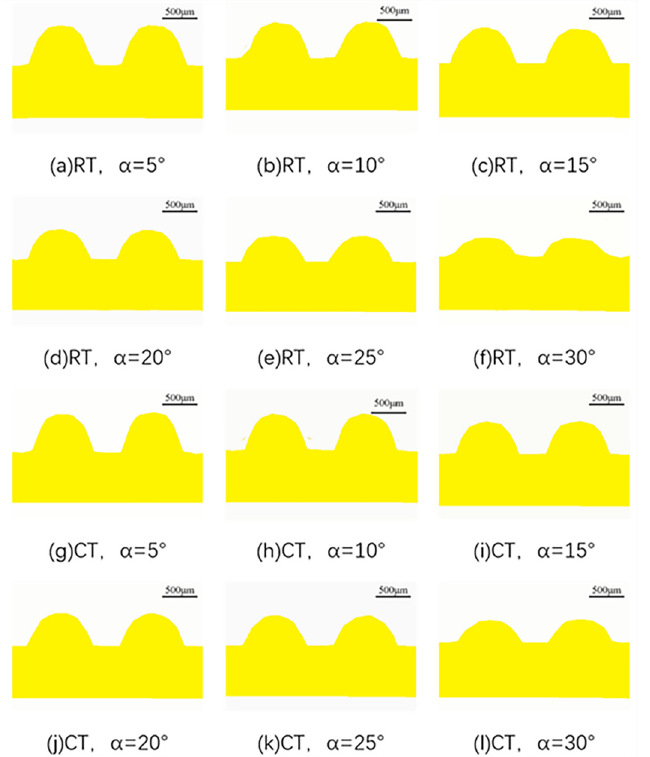
Figure 14. Cross-sectional area of three-dimensional morphology of micro-groove fins produced by extrusion machining under different conditions.